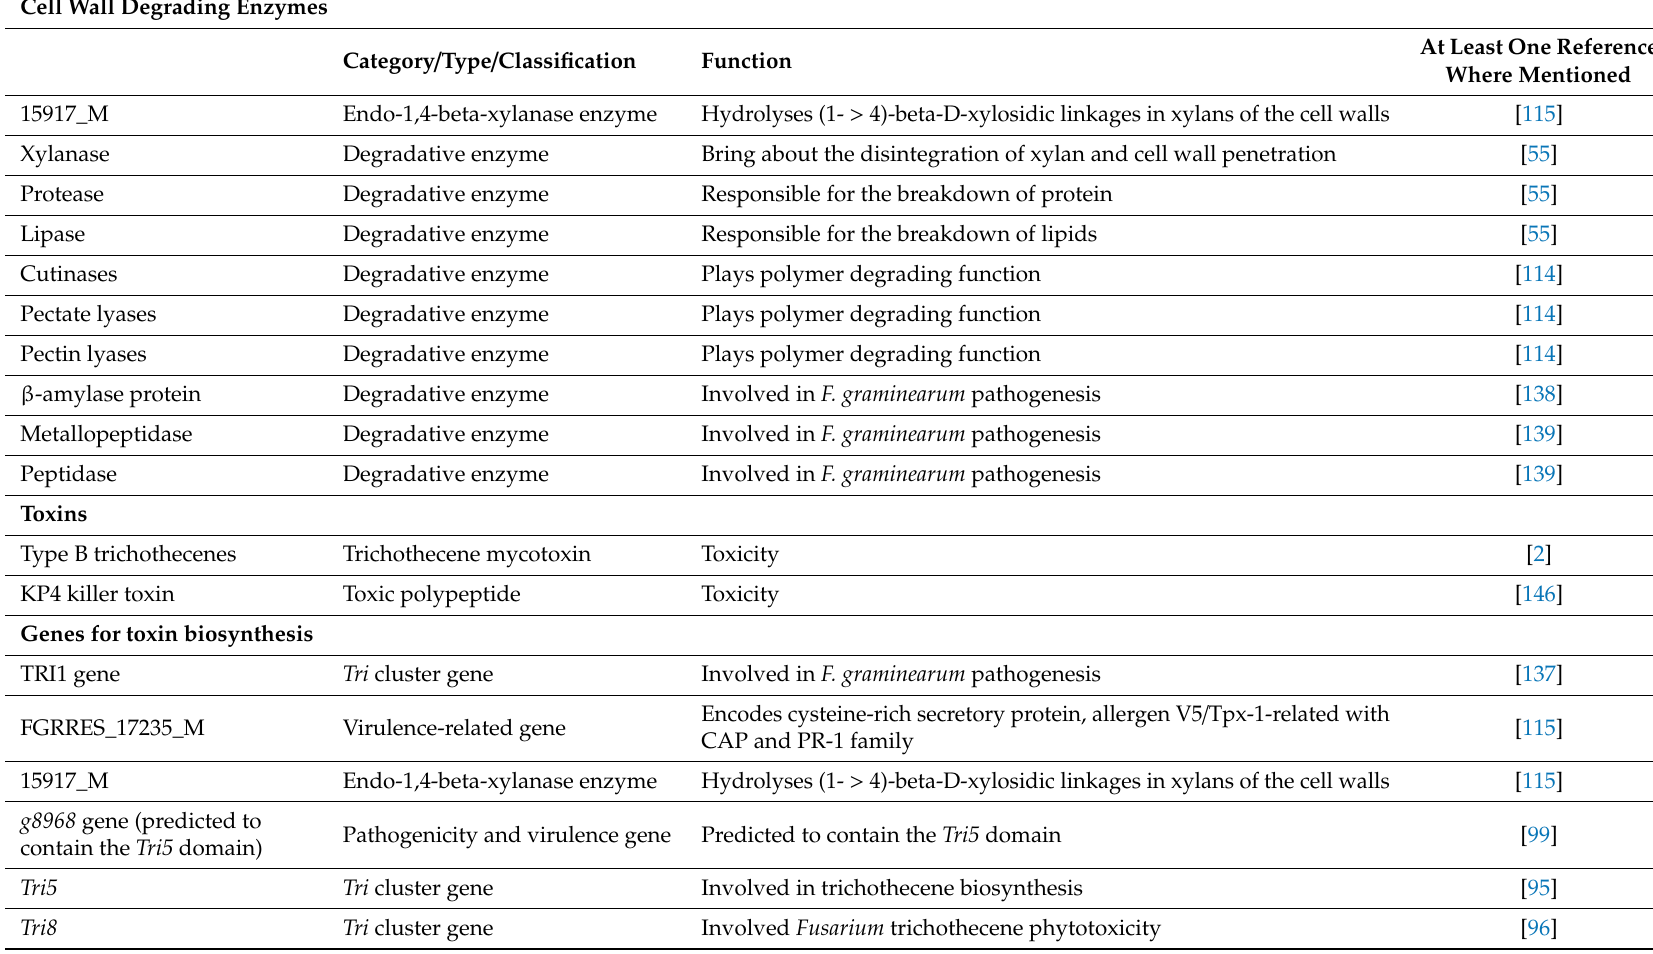
Table 2. List of pathogenicity and virulence factors of Fusarium graminearum , including genes discovered using comparative genomics